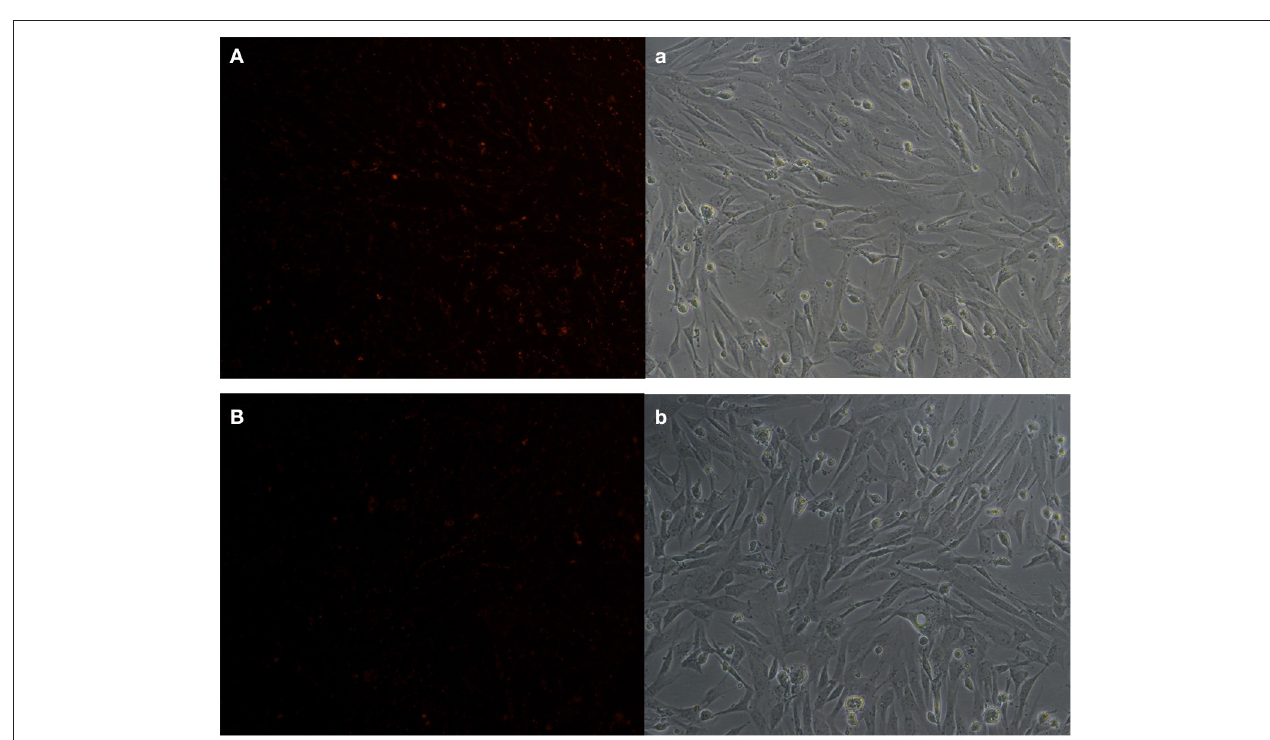
FIGURE 14 | Apoptosis test result of CEF cells (A) control cell ( a : bright field image of A ), (B) REV infected cell ( b : bright field image of B ). We tested the mitochondrial membrane potential of two group cells; exposure time was set as 200ms. The results showed that control cells were reacted with a higher fluorescent signal compared with REV infected cell, which meant REV can inhibit apoptosis of